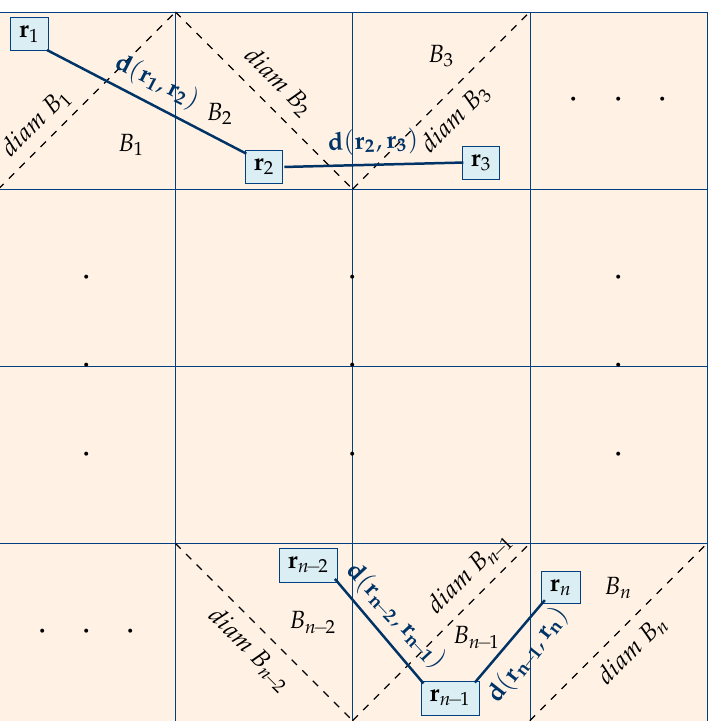
Figure 4. The expected distances between restaurants located in adjacent